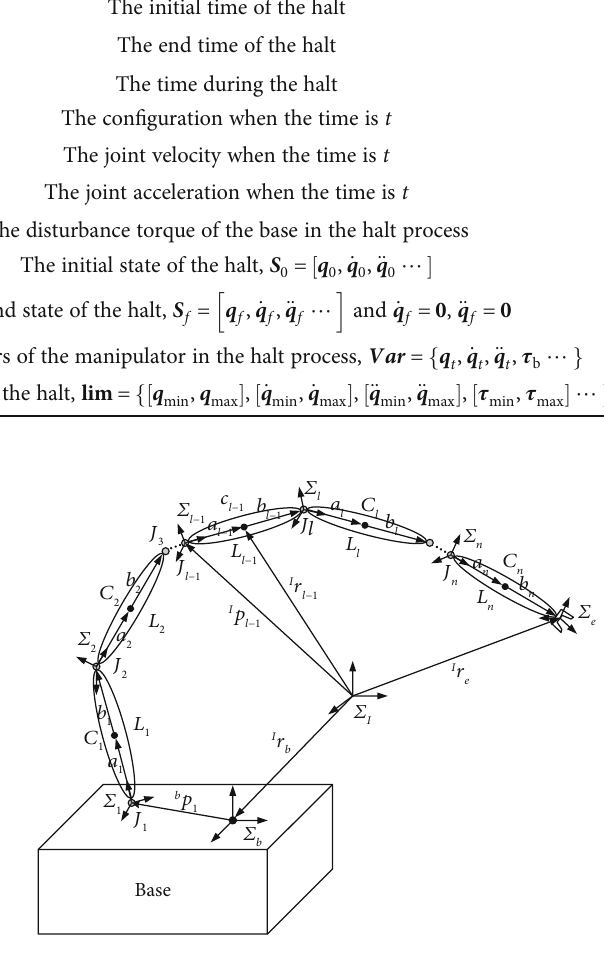
Figure 2: The kinematic model of n -DOF space manipulator without a joint-locked